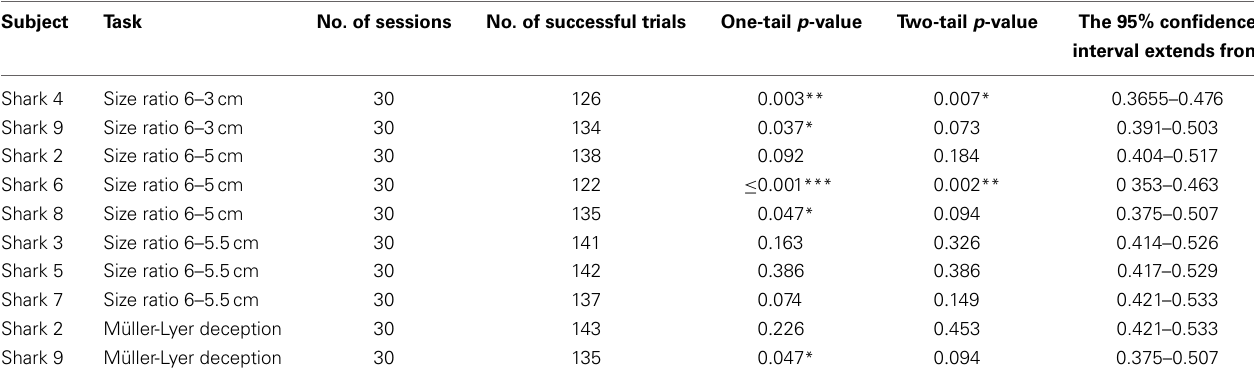
Table 4 | Sign and binomial test and 95% confidence interval to determine if those sharks, who did not reach the learning criterion within 30 sessions for single size pairs (Experiment 3a) or the Müller-Lyer deception (Experiment 3b) chose the positive (rewarded) stimulus significantly more often than the negative (unrewarded)